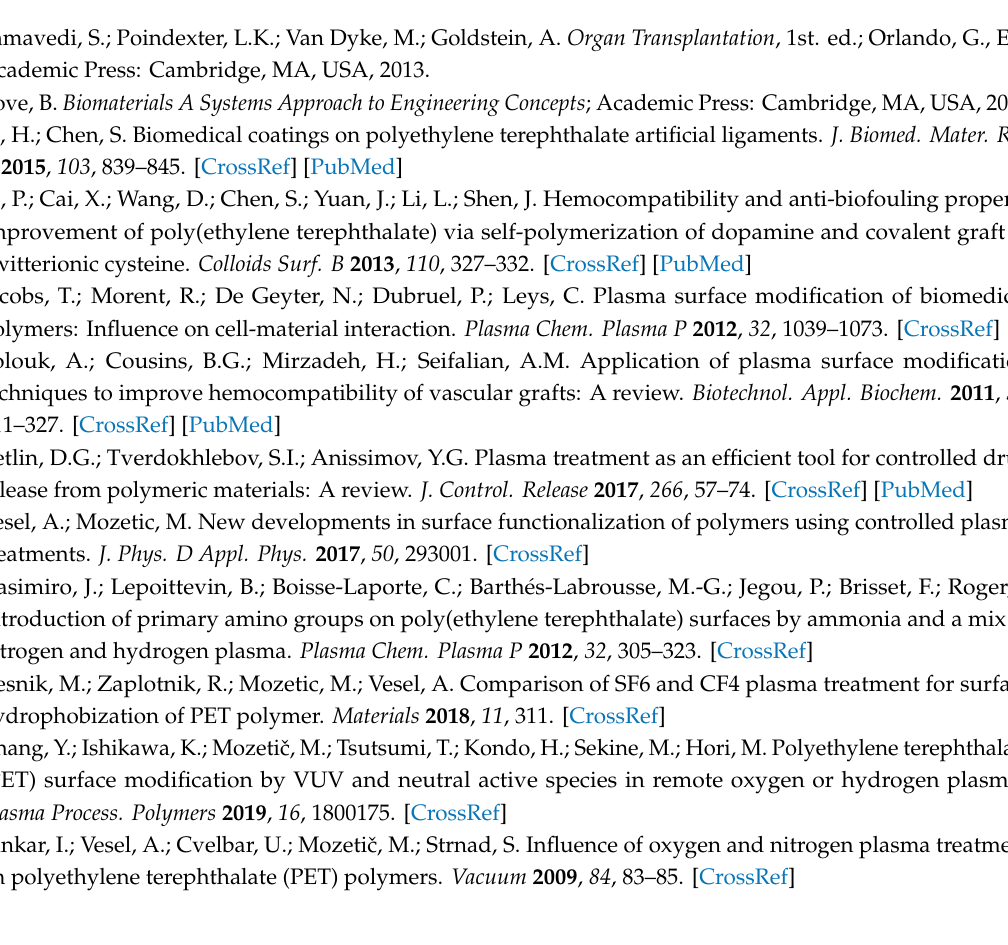
Figure S1: C1s and O1s spectra of plasma-treated PET films, Figure S2: SEM micrographs of non-treated PET film and chitosan-coated plasma-treated PET films, Figure S3: Fluorescent microscopy of FITC-labeled initial and plasma-treated PET films after immobilization of chitosan, Figure S4: MTT-proliferation assay results (OD value) for human mesenchymal stem cells onto initial and plasma-treated PET films with / without chitosan-coating (24 and 48 h in